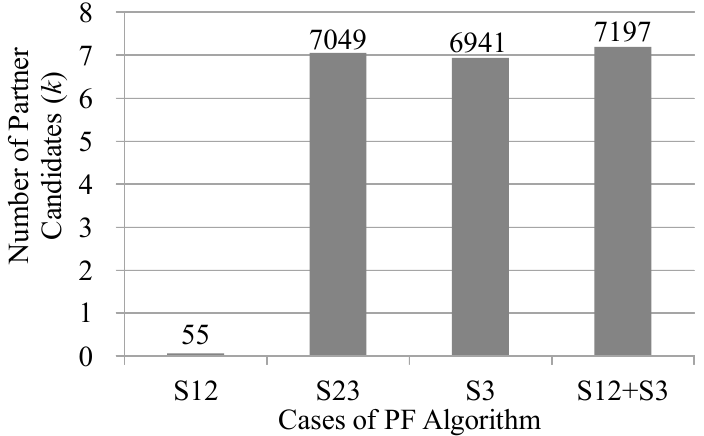
Figure 8. Numbers of candidate partners with different strategies.